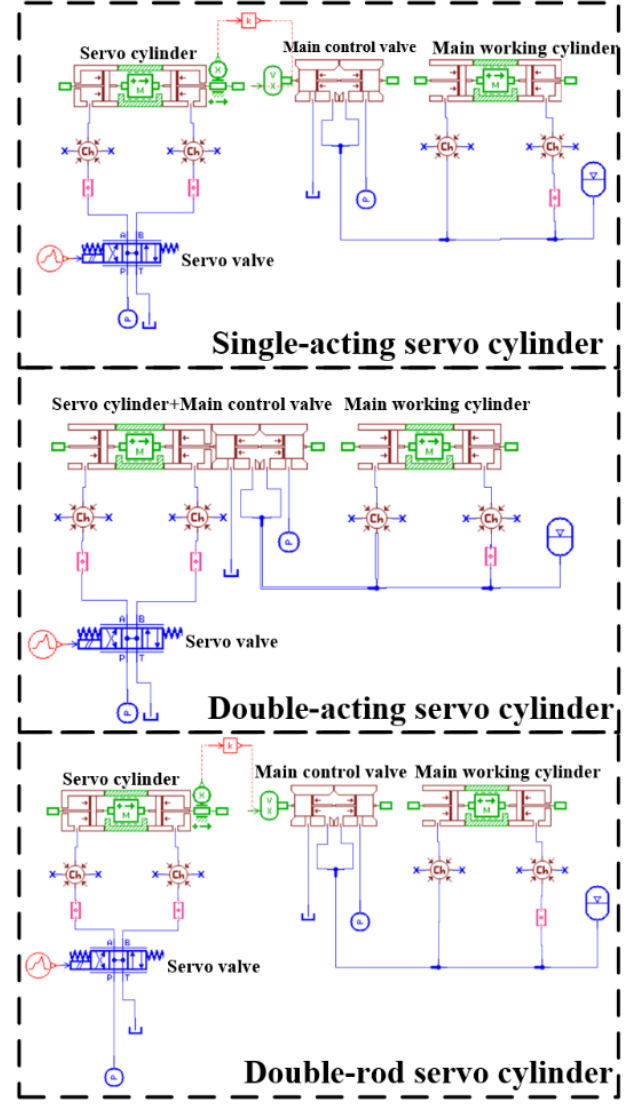
Figure 9. The physical simulation model of the main system. Table 1. Main parameters in simulation